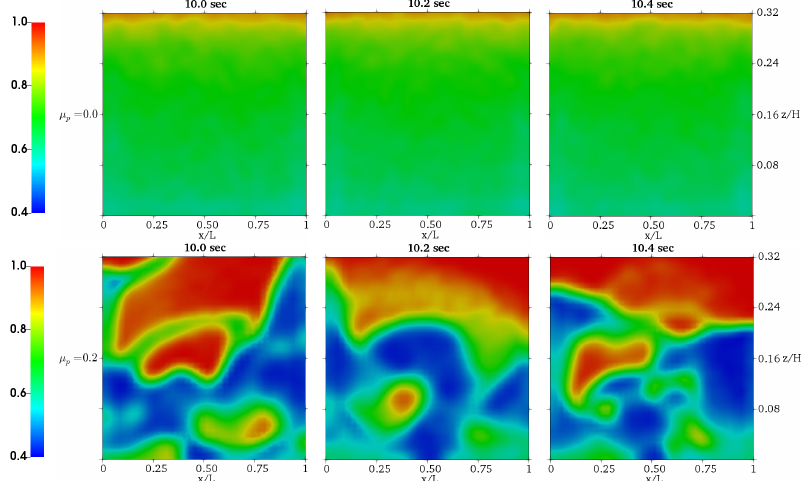
Figure 15. Instantaneous gas volume fraction, with µ w = 0.1. Upper panel: µ p = 0. Bottom panel: µ p = 0.2. Re p = 70 and bed weight 75